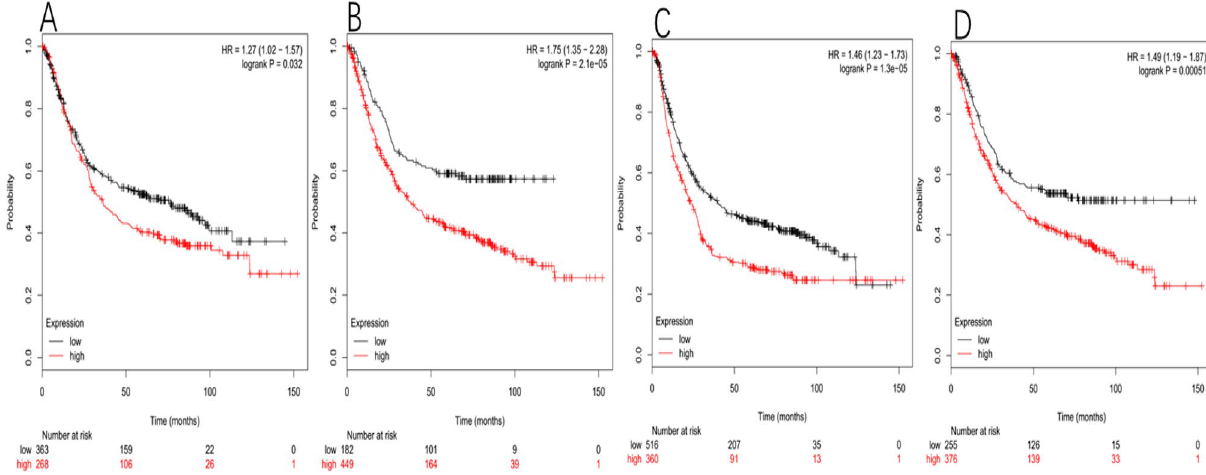
Figure 1. For DLL1, The Affymetrix ID is: 224215_s_at. ( A ) OS curves are plotted for GC patients (n = 631). The Affymetrix ID is: 227938_s_at. ( B ) OS curves are plotted for GC patients (n = 631). For DLL3, The Affymetrix ID is: 219537_x_at. ( C ) OS curves are plotted for GC patients (n = 876). The Affymetrix ID is: 222898_s_at. ( D ) OS curves are plotted for GC patients (n =